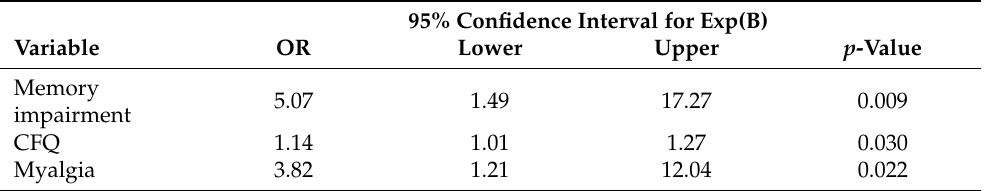
Table 6. Results of the backwards binary logistic regression model investigating independent associa- tions with self-reported brain fog. 95% Confidence Interval for Exp(B) OR Lower